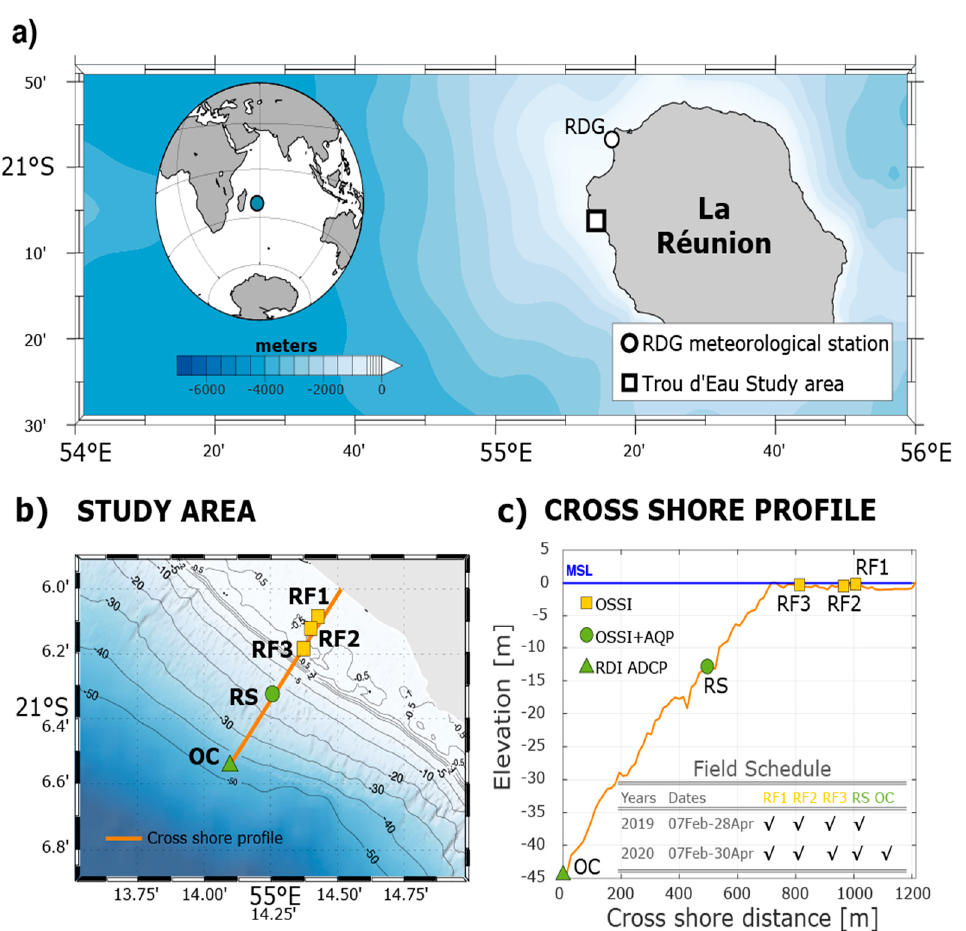
Figure 4. Overview of the experimental setup deployed in “Trou d’Eau” (Réunion Island) in February–April 2019 and 2020. ( a ) Coastal study area, ( b , c ) details of the cross-shore transect instrumented during the experiments. The stations are labeled OC for ocean offshore, RS for reef-slope, and RF for reef-flat. In ( c ), labels OSSI, AQP and RDI ADCP correspond to wave gauges, Nortek AQuadopp current Profiler, and RDI ADCP current profiler, respectively. Instrument deployment dates are indicated in ( c ).